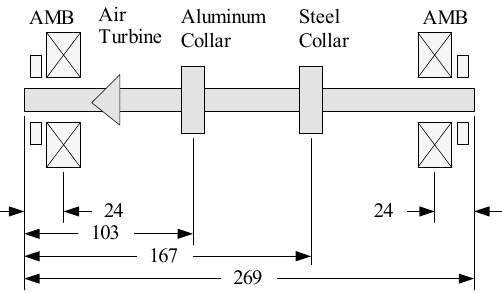
Figure 4. Rotor configuration. Dimensions in mm.